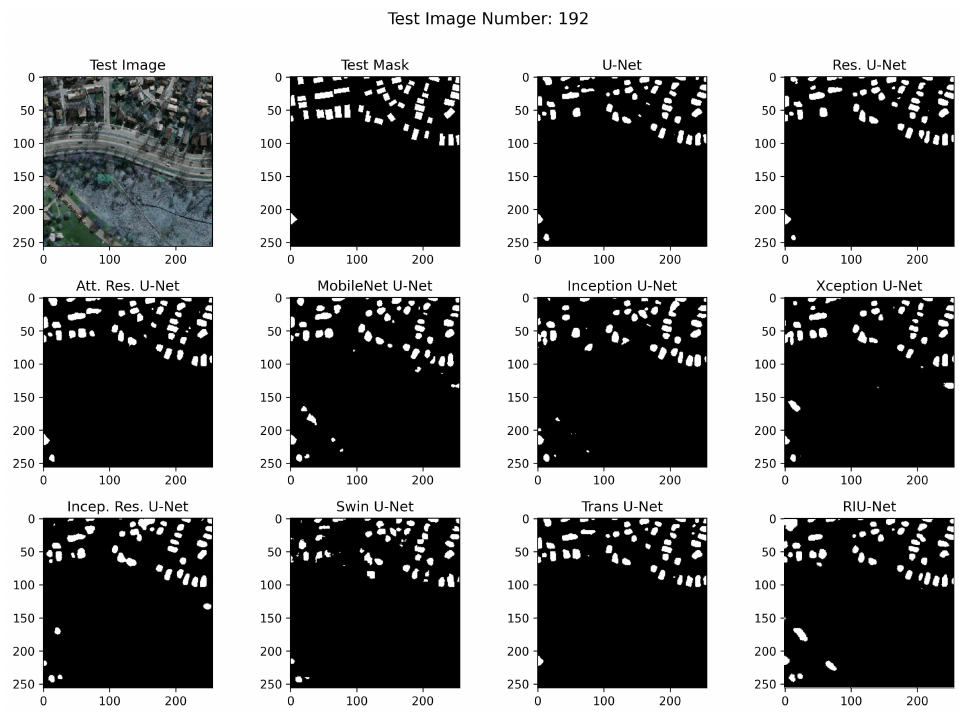
Figure 11. Massachusetts Small test set image no. 192 segmentation